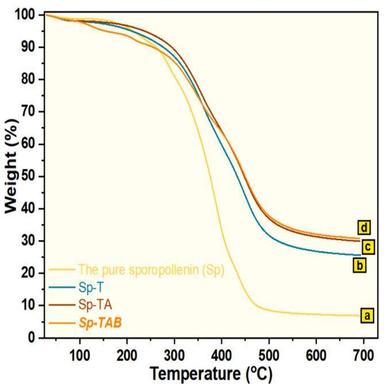
TGA plots of (a) the pure Sp, (b) Sp-T, (c) Sp-TA and (d) the fluorescent Sp-TAB hybrid material.